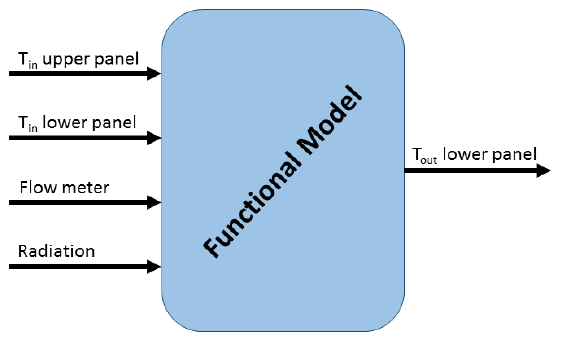
Figure 4. General schema of the functional model.